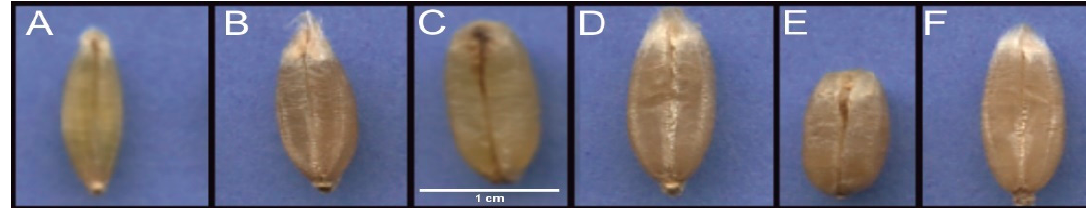
Figure 1. Typical kernel images of the analyzed wheat species. A —einkorn, B —emmer, C —durum wheat, D —Polish wheat, E —bread wheat, F —spelt. Table 1. The characteristics of the main shape and color descriptors.